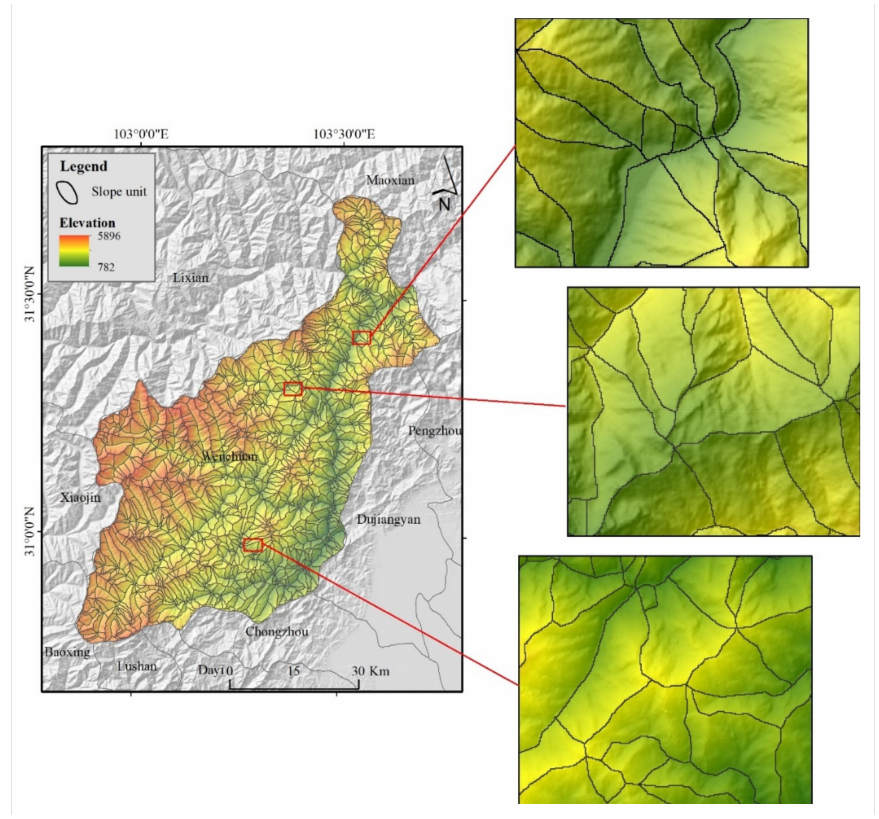
Figure 7. Slope units of the study area.